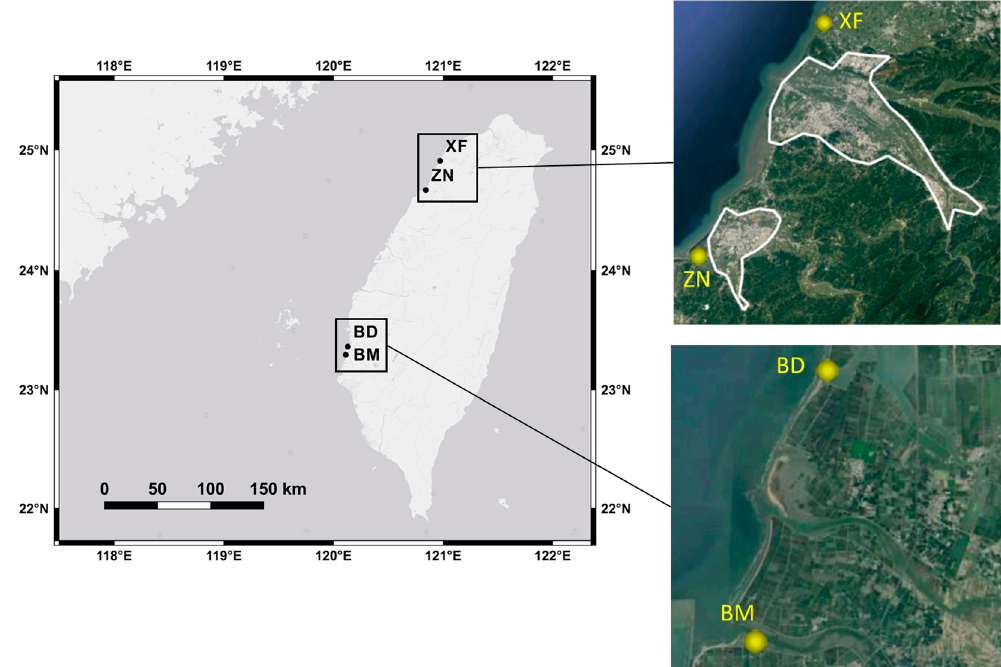
Figure 1. Map of studied mangrove sites at Xinfeng (XF), Zhunan (ZN), Budai (BD), and Beimen (BM) in Taiwan. The urban areas near XF (15,991 ha) and ZN (3807 ha) are shown by the white polygons. Non-urban area was observed near BD or BM. (Map sources: Left: QGIS 2.18.14; Right: Google Earth). Table 1. Meteorological conditions, mangrove features, soil texture, and water nutrient concentrations at the four mangrove sites: Xinfeng (XF), Zhunan (ZN), Budai (BD), and Beimen (BM). Site XF ZN BD